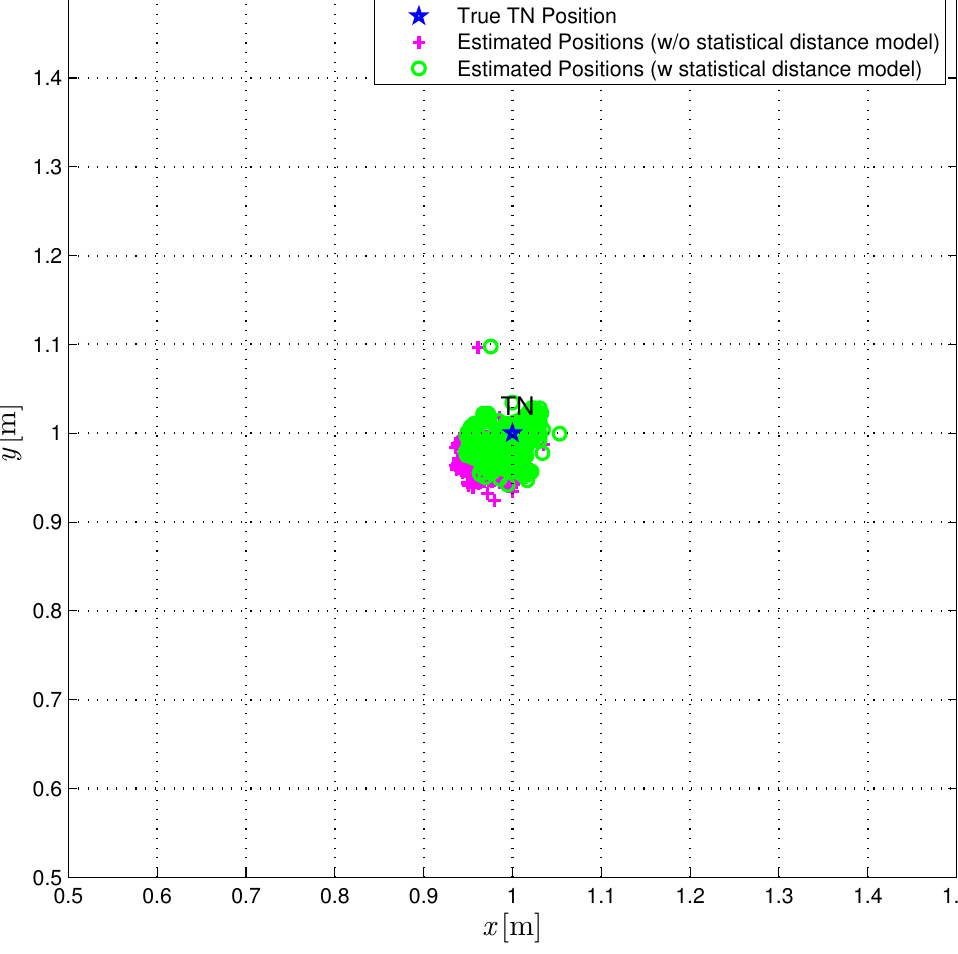
Figure 9. CDFs of the distance errors obtained with the TSML localization algorithm in Figure 8 without (solid line) and with (dashed line) the statistical model. 4.2. “Bad” Geometrical Scenario We now consider the scenario shown in Figure 5b, where the TN is outside the convex hull of the ANs, which have the following coordinates (in meters): AN 1 = [ 0.5, 4.5 ] AN 2 = [ 4, 3 ] AN 3 = [ 2.5, 1 ] , (29)